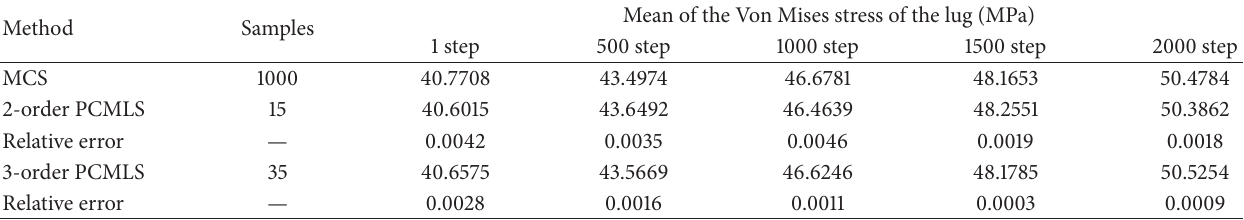
Table 5: Comparative results of the mean of the Von Mises stress of the lug along the time